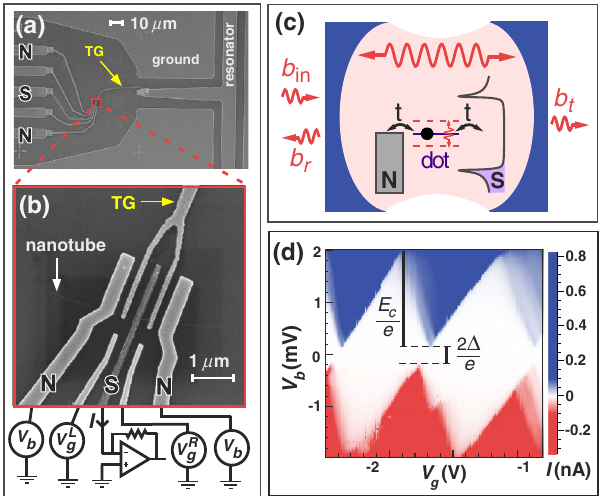
FIG. 1. Panels (a) and (b): Scanning electron micrograph of the microwave resonator and the quantum dot circuit. Panel (c): Principle of our setup. The dot level is tunnel coupled to the N and S reservoirs and modulated by the cavity electric field. Panel (d): Current through the S contact versus the effective gate voltage V and the bias voltage V g b